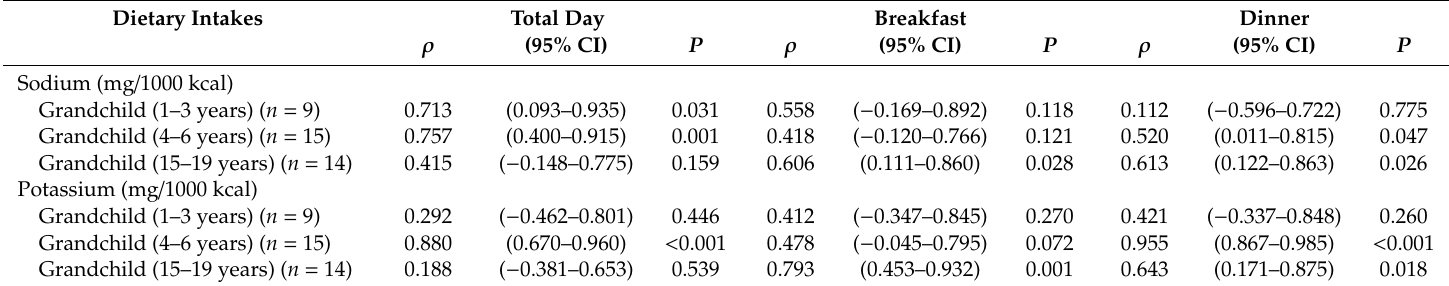
Table 3. Grandparent–grandchild correlations in sodium and potassium